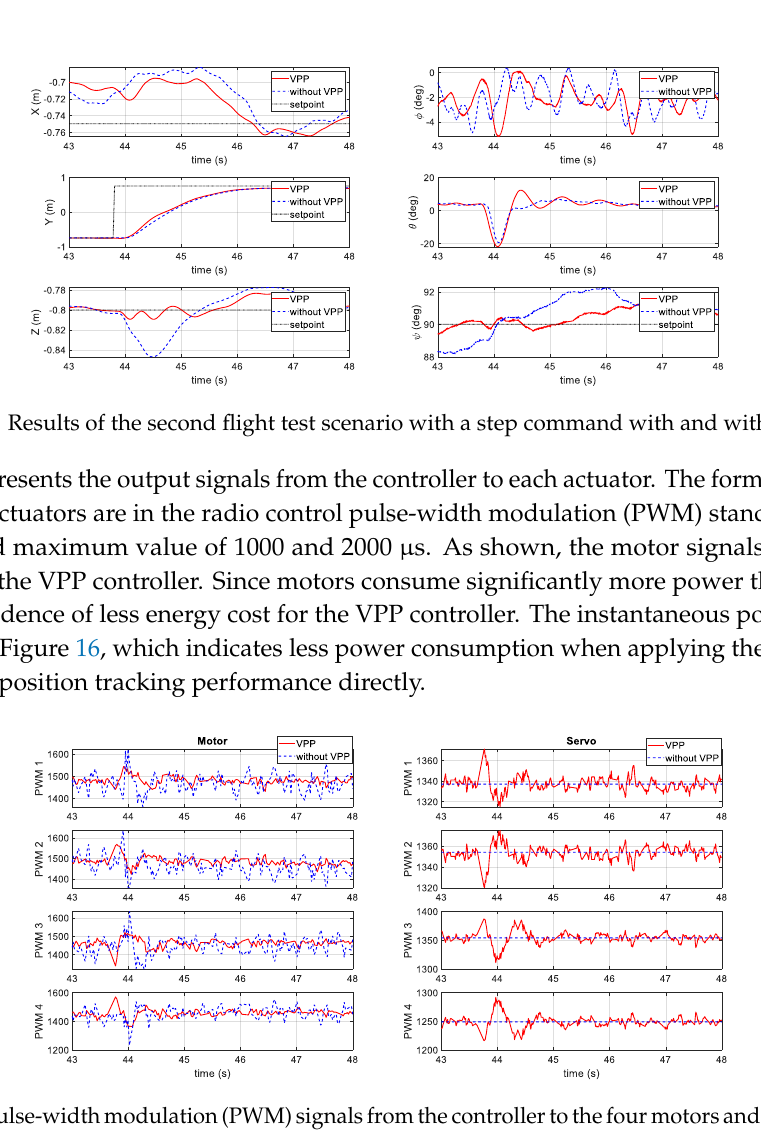
Figure 13. Instantaneous power during the first flight test scenario.